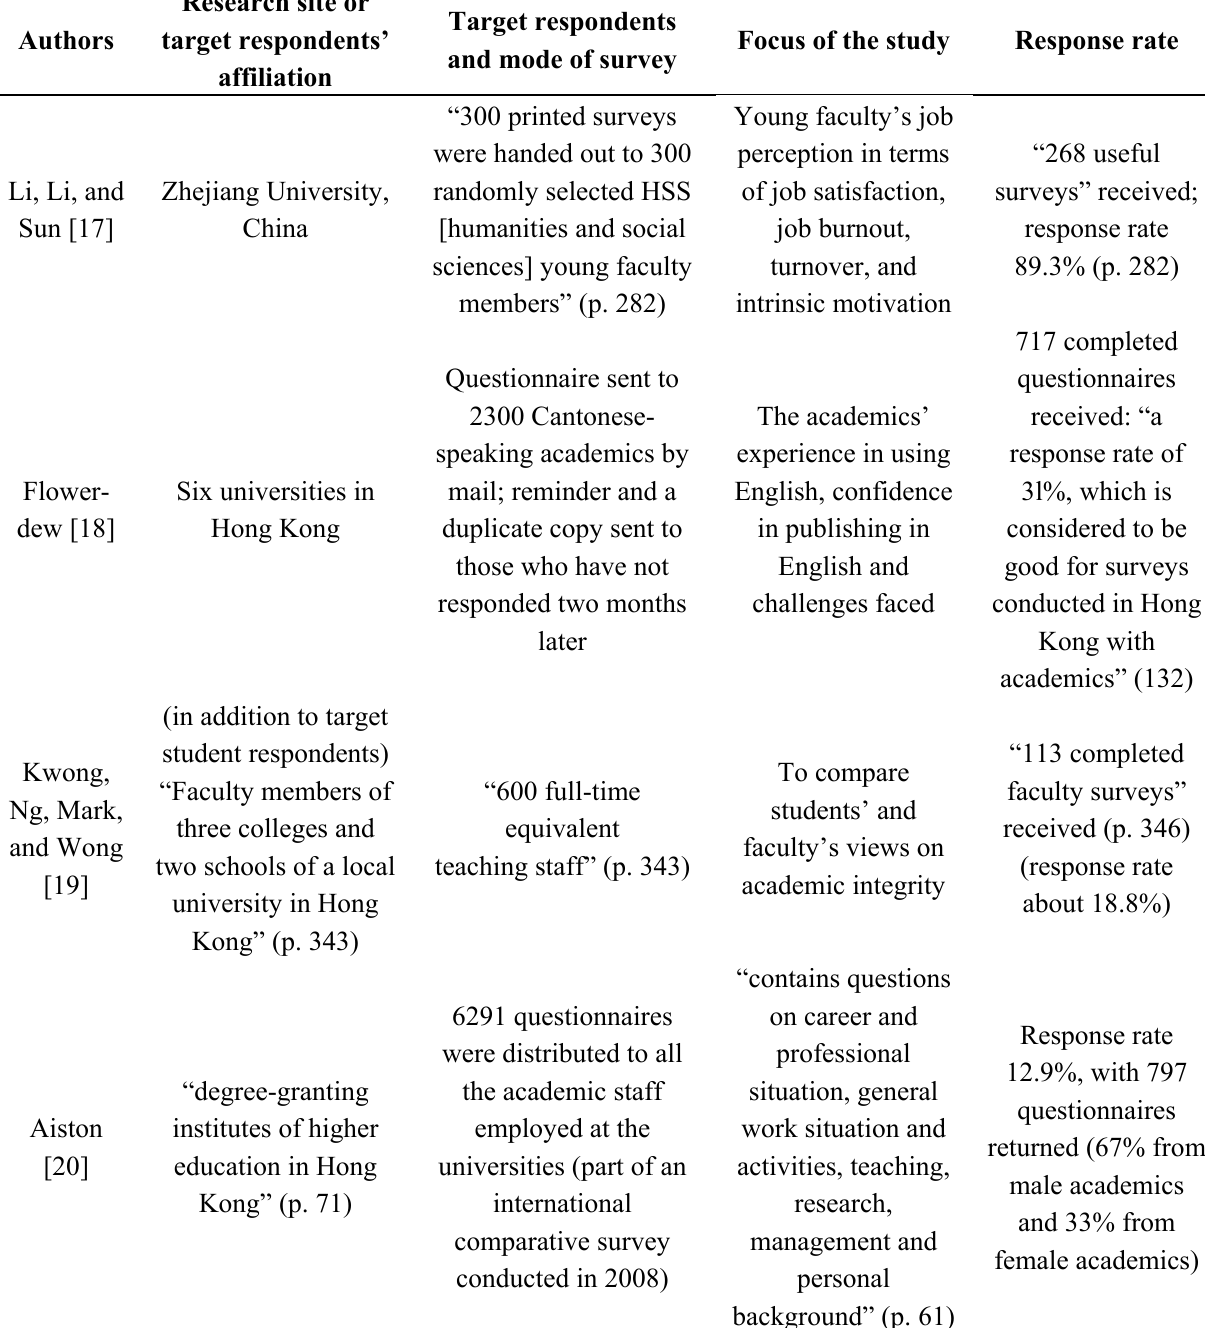
Table 3. A summary of five surveys conducted by language professionals or education researchers in universities in several Chinese-speaking